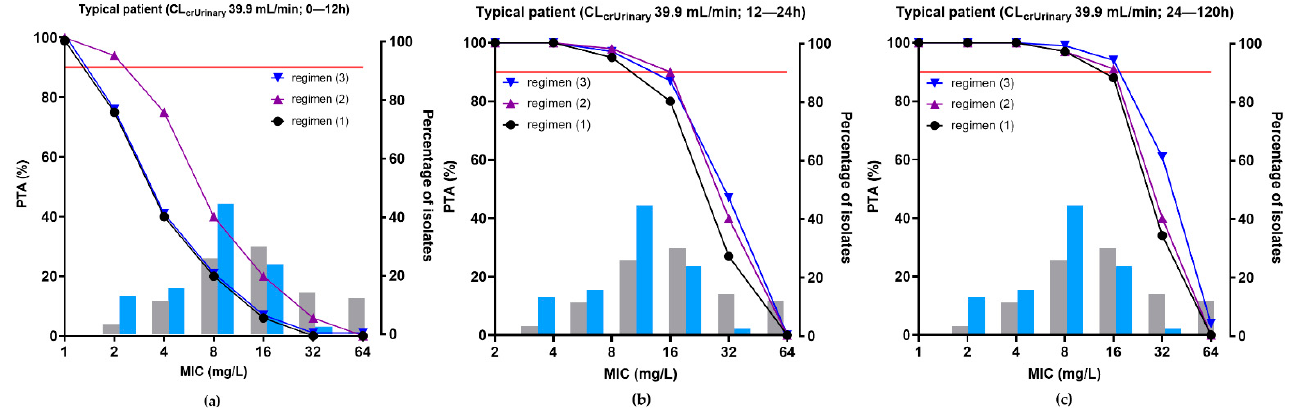
Figure 5. PTA of temocillin in ascitic fluid for typical septic patients (Median CL CRurinary = 39.9